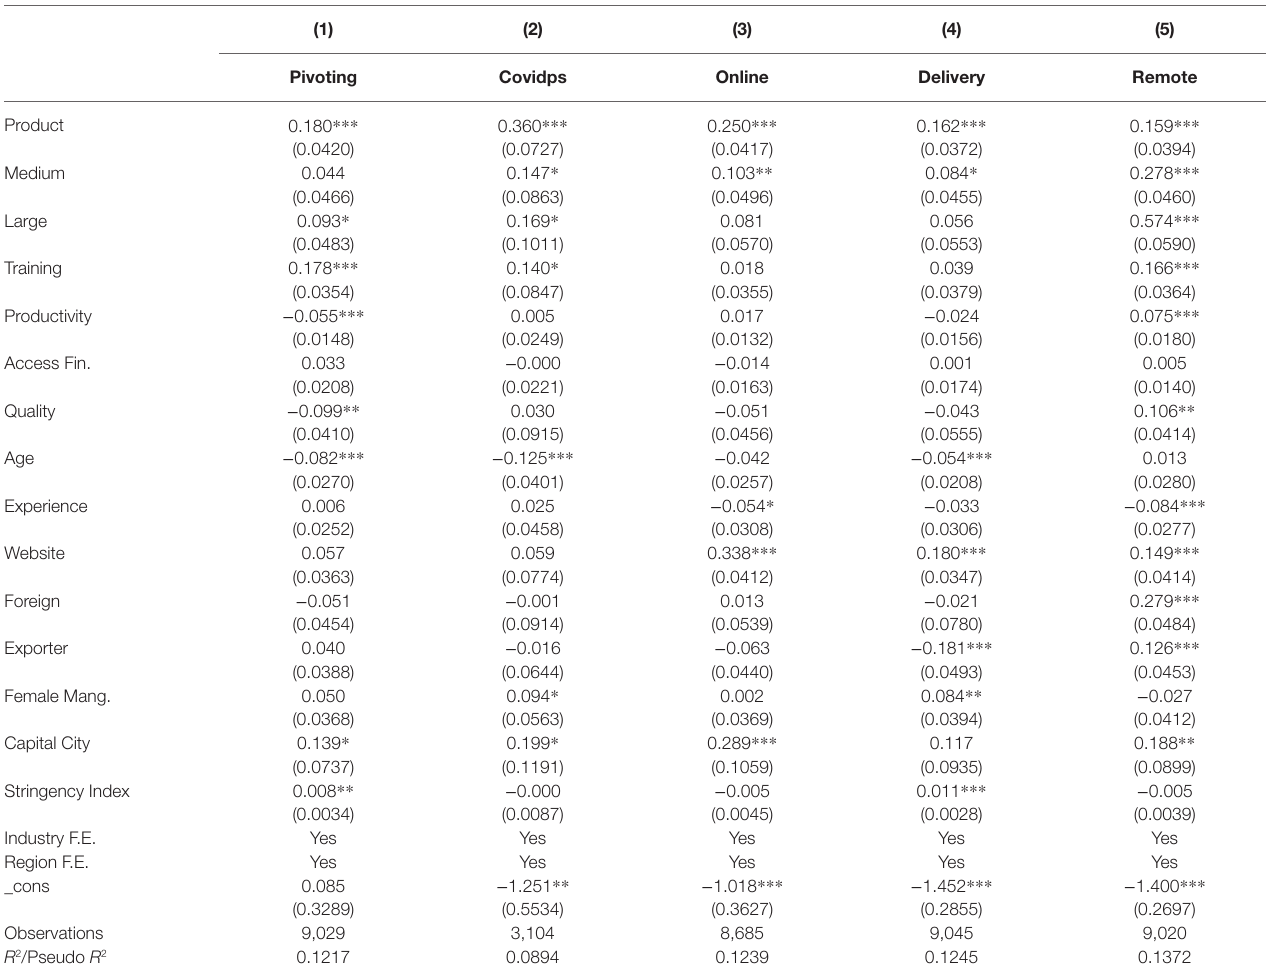
TABLE 4 | Product innovation and